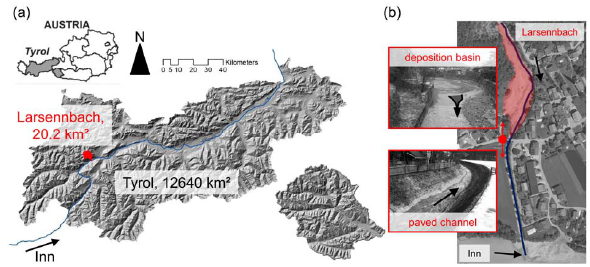
Fig. 1. (a) Location of the Larsennbach torrent catchment in Northern Tyrol; (b) situation at the torrent’s debris cone – deposition basin and paved channel in the surroundings of populated area.